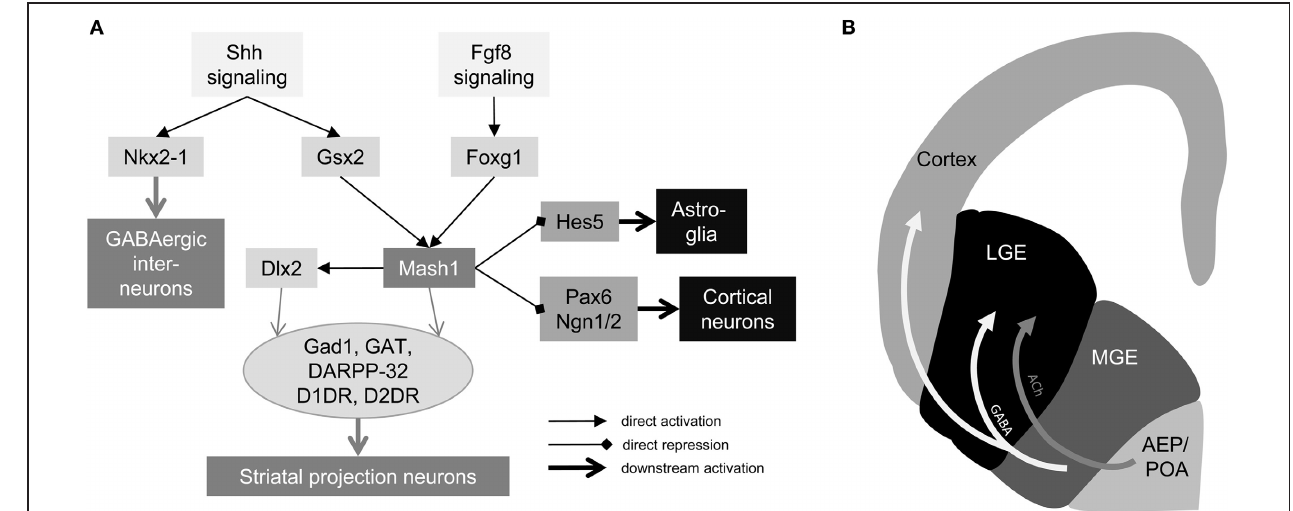
Schematic drawing of a coronal section of a rat E14 fetal forebrain (left hemisphere). Light gray arrow indicates tangential cell migration of acetylcholinergic precursors from the AEP/POA to the LGE. White arrows indicate migration of GABAergic progenitors from the MGE to the LGE and cortex. ACh: acetylcholine, AEP: anterior entopeduncular area, D1DR: dopamine receptor D1, D2DR dopamine receptor D2, Gad1: